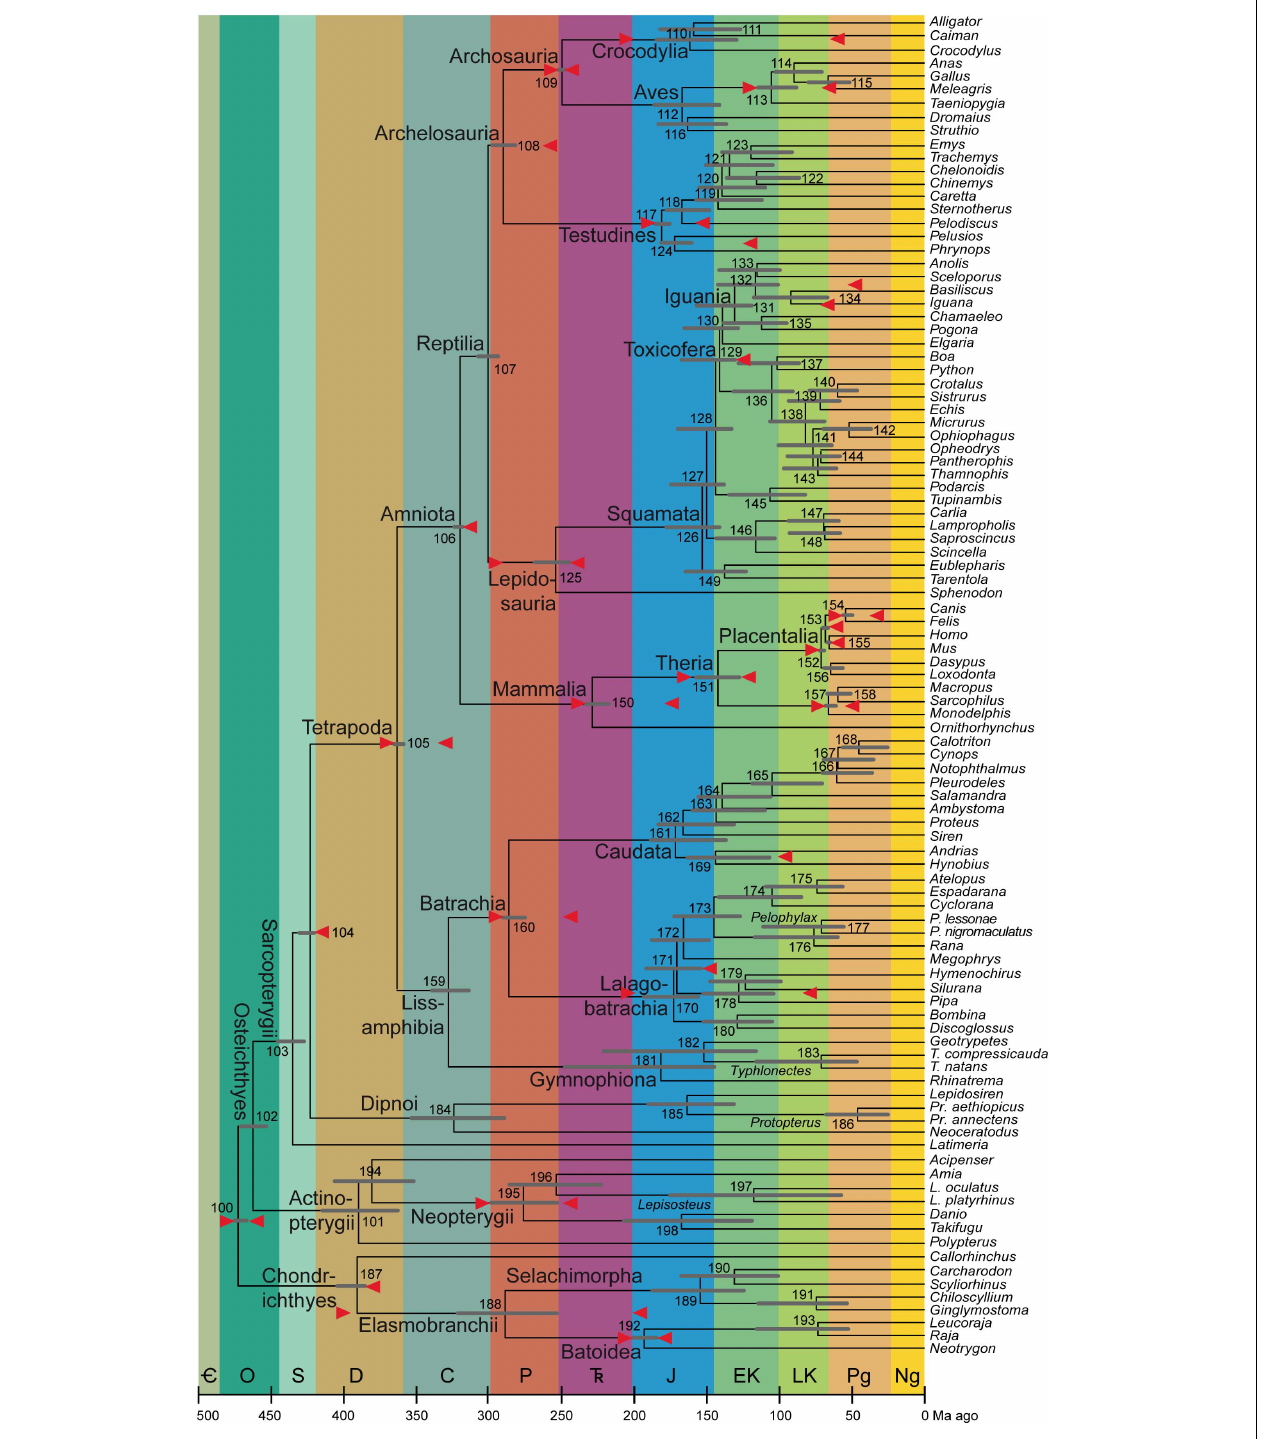
FIGURE 1 | Average timetree resulting from application of the calibrations described here (mostly in the Supplementary Material ). As in Table 2 and in Irisarri et al. (2017: figure 3), the bars on the nodes are the superimposed 95% credibility intervals from the two runs in PhyloBayes. The calibrations are shown as red arrows horizontally in line with the nodes they apply to; note that the arrow that is almost aligned with the branch of Lalagobatrachia and the one that is almost aligned with the terminal branch for Silurana are the maximum and minimum ages of Node 178 (Pipidae), the one on Iguana to Node 131 (Iguania), and the one on Pelodiscus to Node 117 (Testudines). The abbreviated genus names are spelled out as clade names on their common branches; where only one species per genus is sampled,